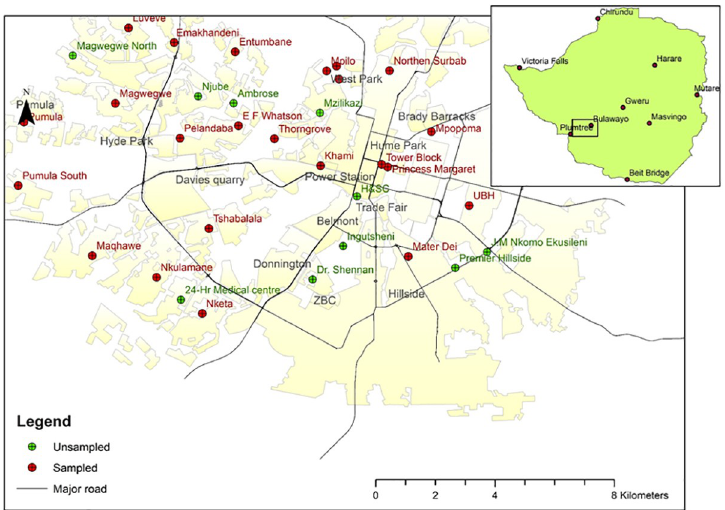
Fig 1. Map showing all health facilities in Bulawayo district and highlighting the 24 sampled health facilities. Baselayer created using ARCGIS